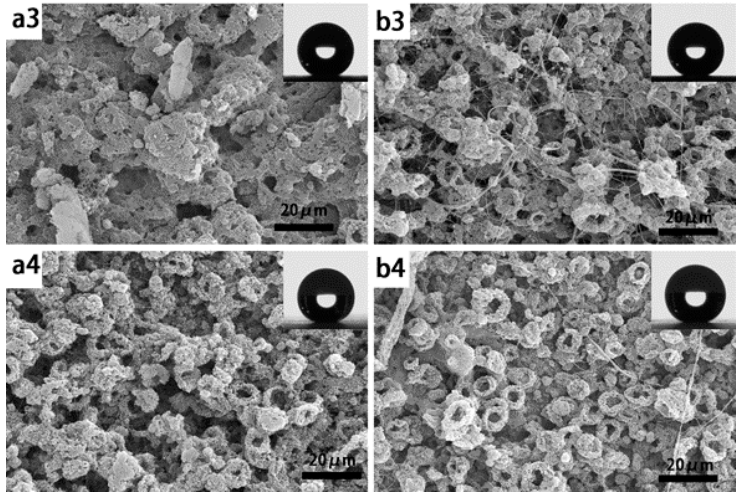
Figure 5. SEM images of the best combination by DE and regression in each round of experiments. ( a1 – a4 ) From a1 to a4, the SEM images show the morphology of electrospun membranes, which have the largest CA value of Iter.1, Iter.2, Iter.3 and Iter.F predicted by the DE algorithm separately. ( b1 – b4 ) From b1 to b4, the SEM images show the morphology of electrospun membranes, which have the largest CA value of Iter.1, Iter.2, Iter.3 and Iter.F predicted by regression separately.